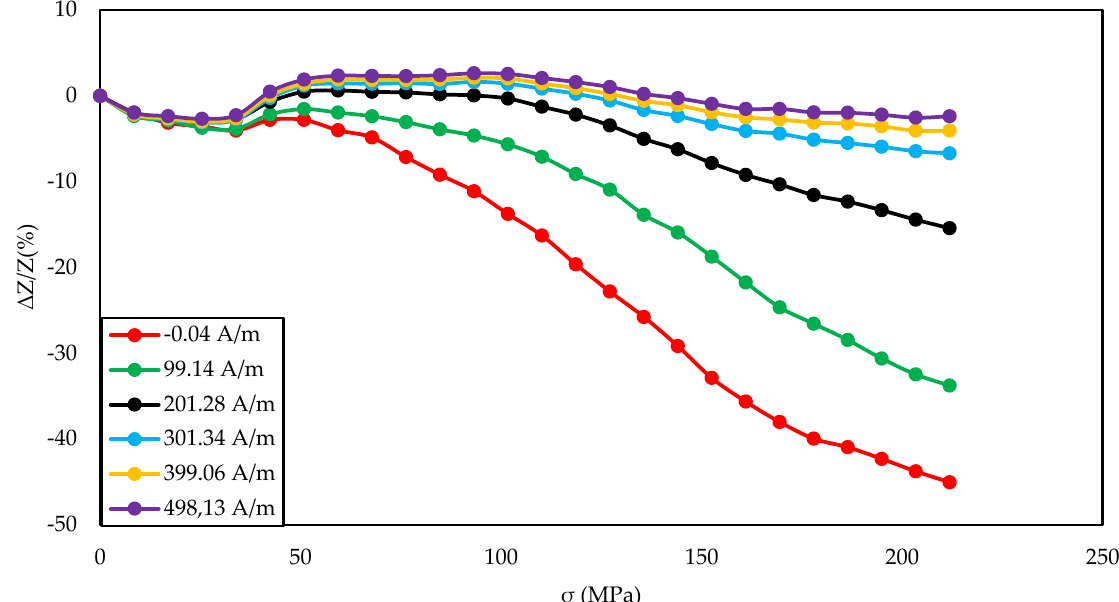
Figure 3. Dependence of impedance in a function of stresses for different magnetizing fields for the as-cast sample.